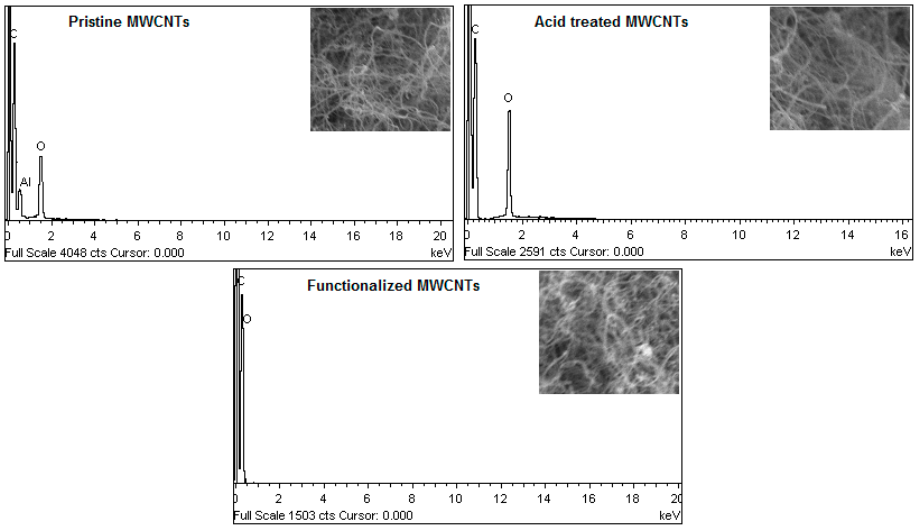
Figure 9. EDX spectra of pristine and chemically modified MWCNTs.